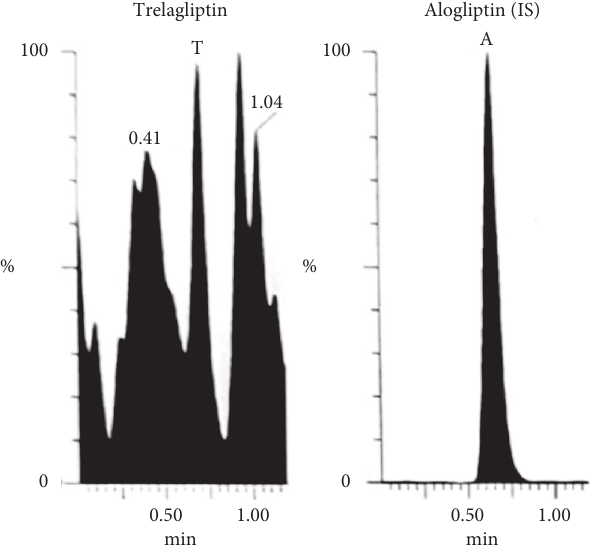
Figure 6: Zero human plasma sample showing IS only.